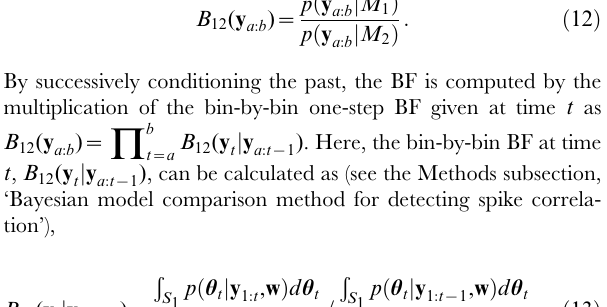
Table 4, here a sample of spike sequences is generated from a pairwise ( r ~ 2 ) time-dependent log-liner model of N ~ 3 neurons. This underlying model is a projection of the full log-liner model examined in Table 4 (dashed lines in Figure 4C) to the pairwise model space. The frequencies of the r th order model that minimizes AIC, BIC, and PDIO are counted by repeatedly applying models with different orders ( r ~ 1,2,3 ) to 100 samples (each with n trials). The most frequently selected models are displayed for the different criteria and for different numbers of trials, n , as in Table 4. The rows for the KL-risk and MSE display the models that minimize the estimates of the KL-risk and MSE.